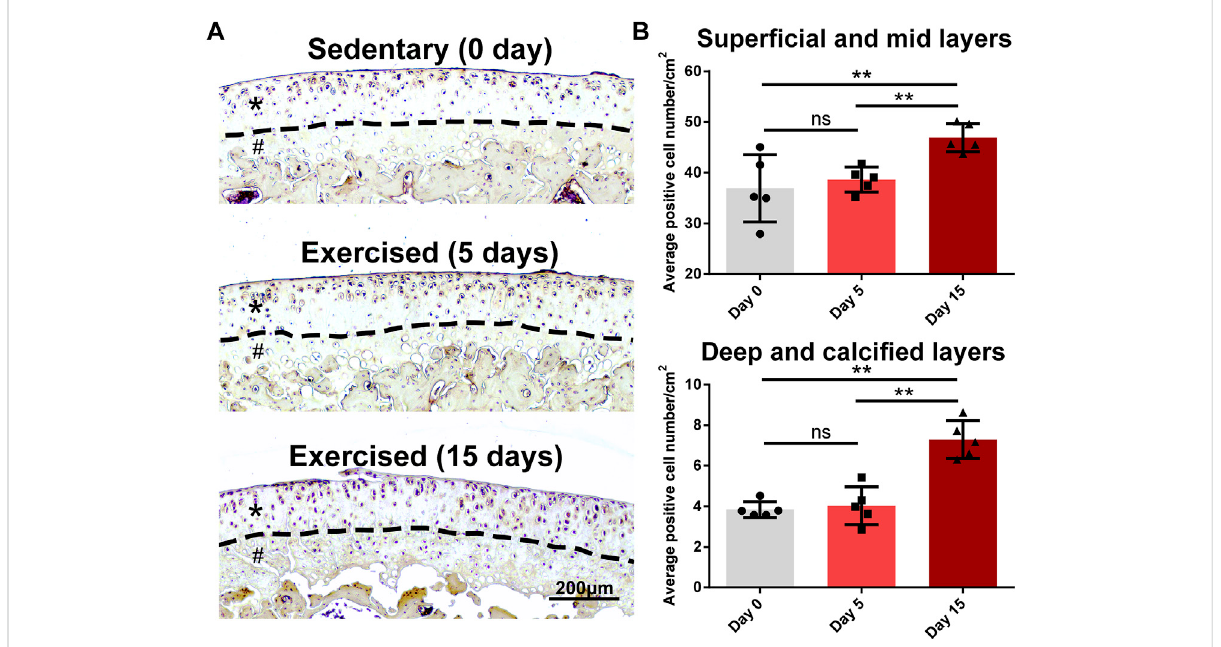
FIGURE 7 Egfr isalateresponsivegeneintheexercisedcartilage. (A) Egfr expressioninthetibialcartilageofthesedentaryandexercisedrats. Egfr ismainly expressedinthesuper fi ciallayerofratcartilage.After15-dayexercise,theexpressionof Egfr wasincreasedintheexercisedcartilagecompared with the sedentary group. Asterisks indicate the super fi cial and mid layers of cartilage. Hashtags indicate the deep and calci fi ed layers of cartilage. (B) The quantitativestatisticsoftheaveragenumbersofEGFR + cells.TheEGFR + cellsofD15increasedinbothsurface(super fi cial/mid)anddeep(deep/ calci fi ed) layers compared with D0 or D5, while no difference between D0 and D5 was identi fi ed. **, p < 0.01, One-way ANOVA; ns, not signi fi